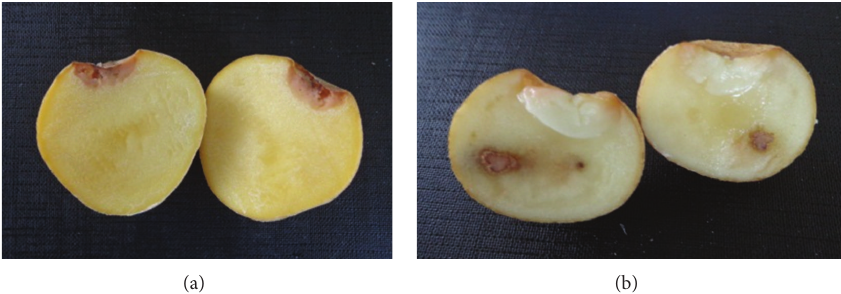
Figure 1: Typical severity of tuber soft rot on potato somaclonal variants (a) A380 and (b) the parent cv. Russet Burbank. Tubers were from in vitro trial 1 and the pathogen was Pectobacterium carotovorum subsp. carotovorum (Pcc) .